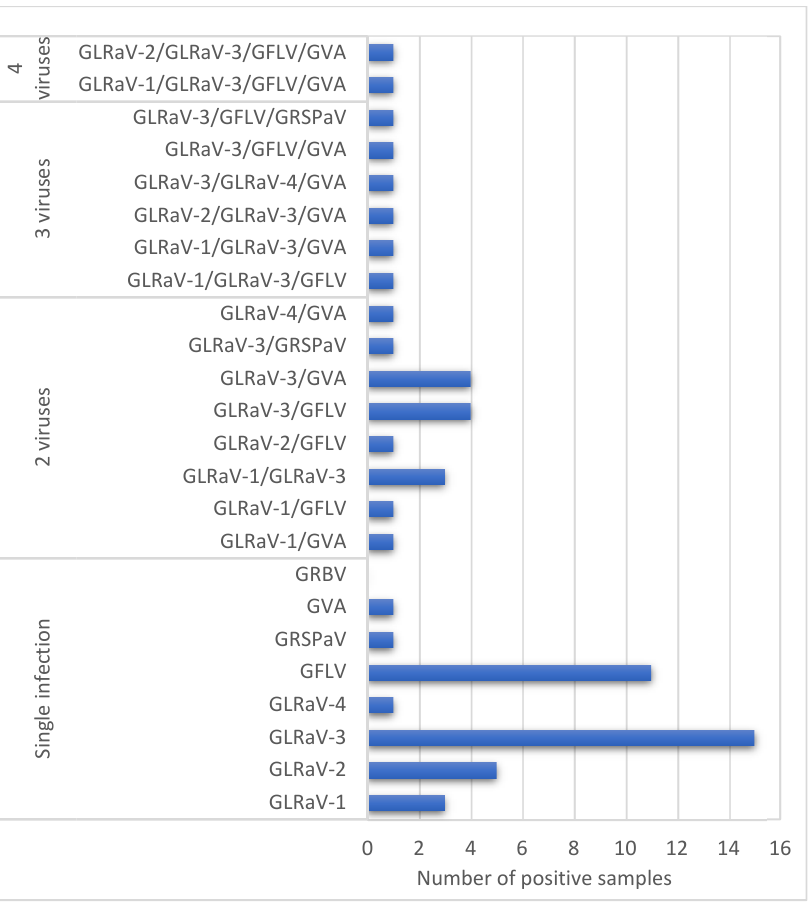
Figure 2. Virus and virus mixed infections detected in the grapevines from northwestern Argentina studied.